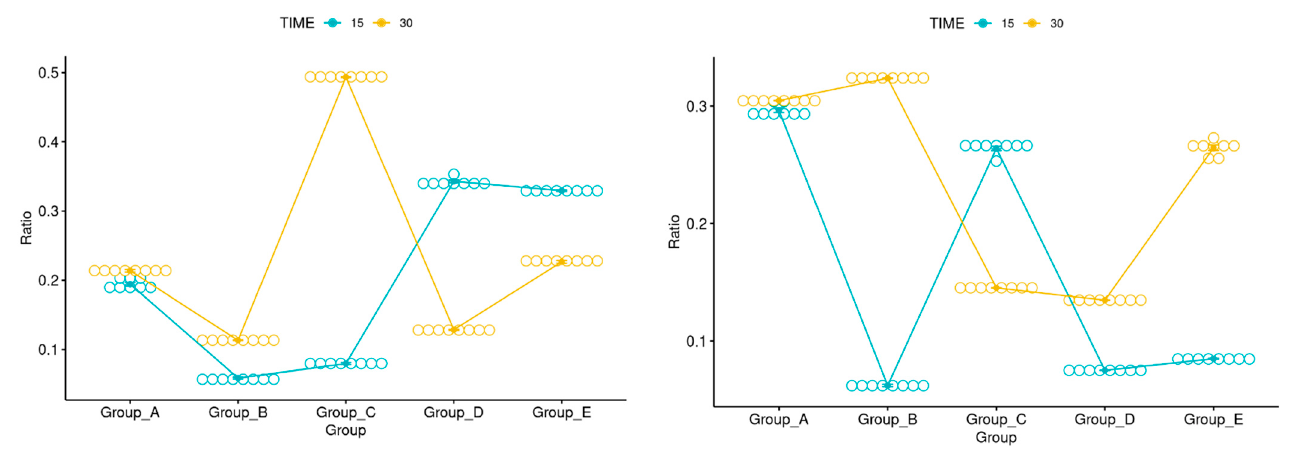
Kidney Bowel Figure 5.